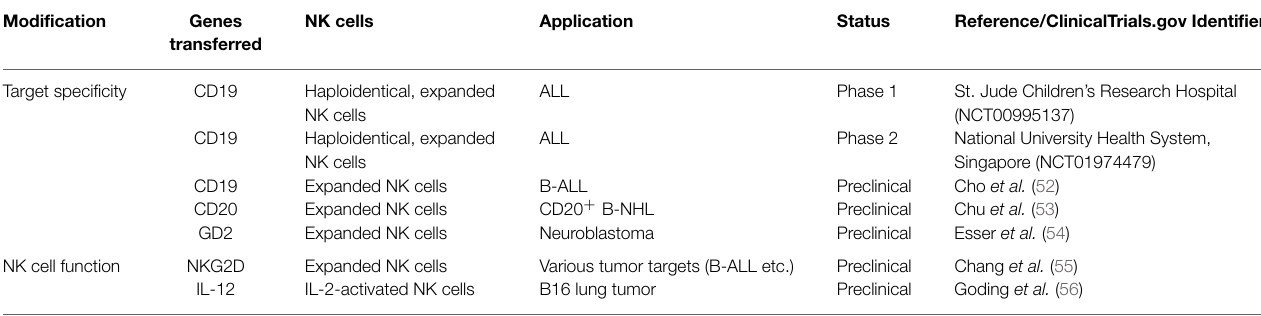
TABLE 2 | Genetically modified, expanded allogeneic NK cells